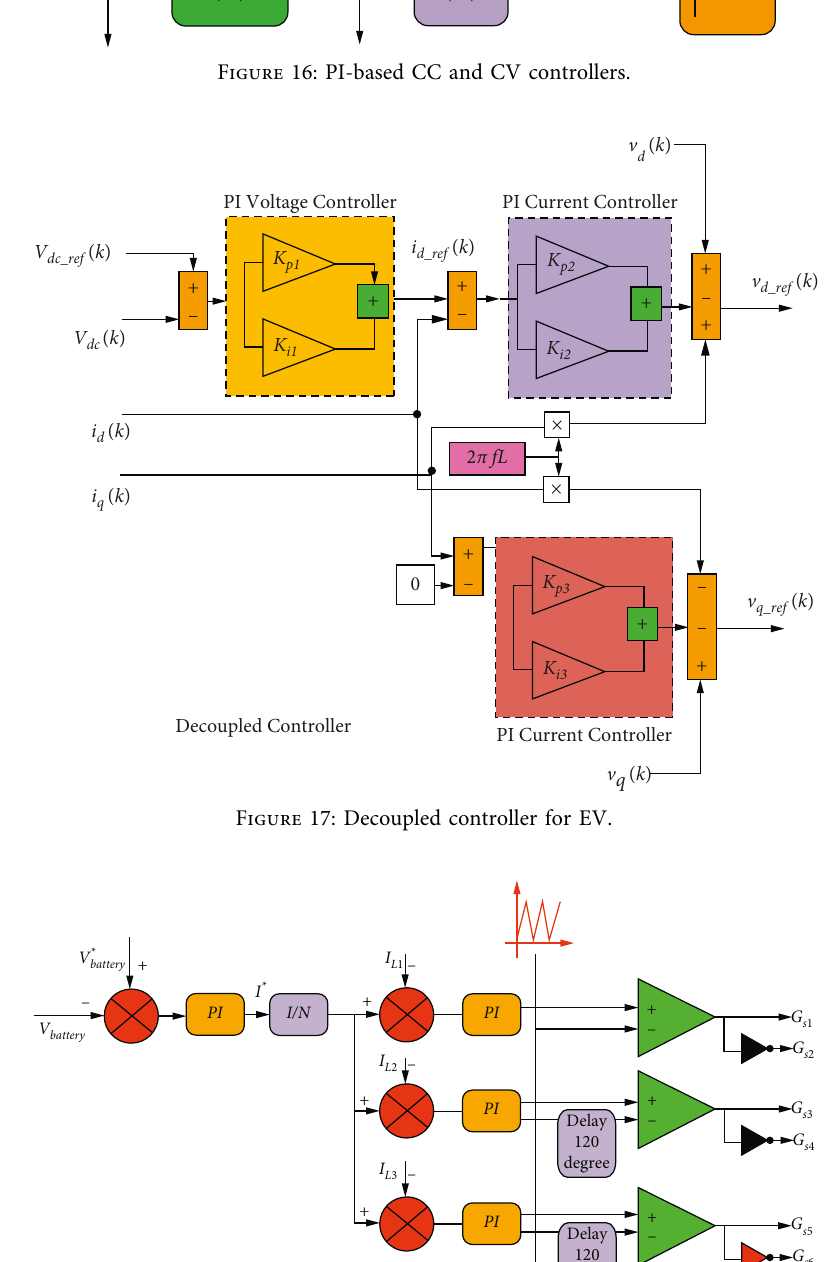
Figure 18: Cascaded controller for a